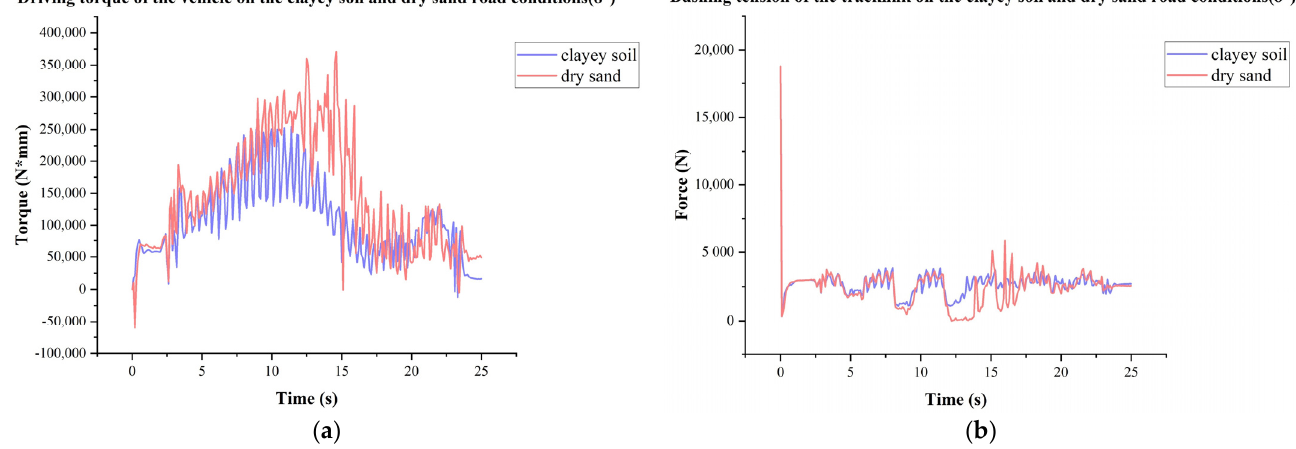
Figure 23. Description of the driving torque ( a ) and the bushing tension ( b ) of the vehicle when fully loaded with